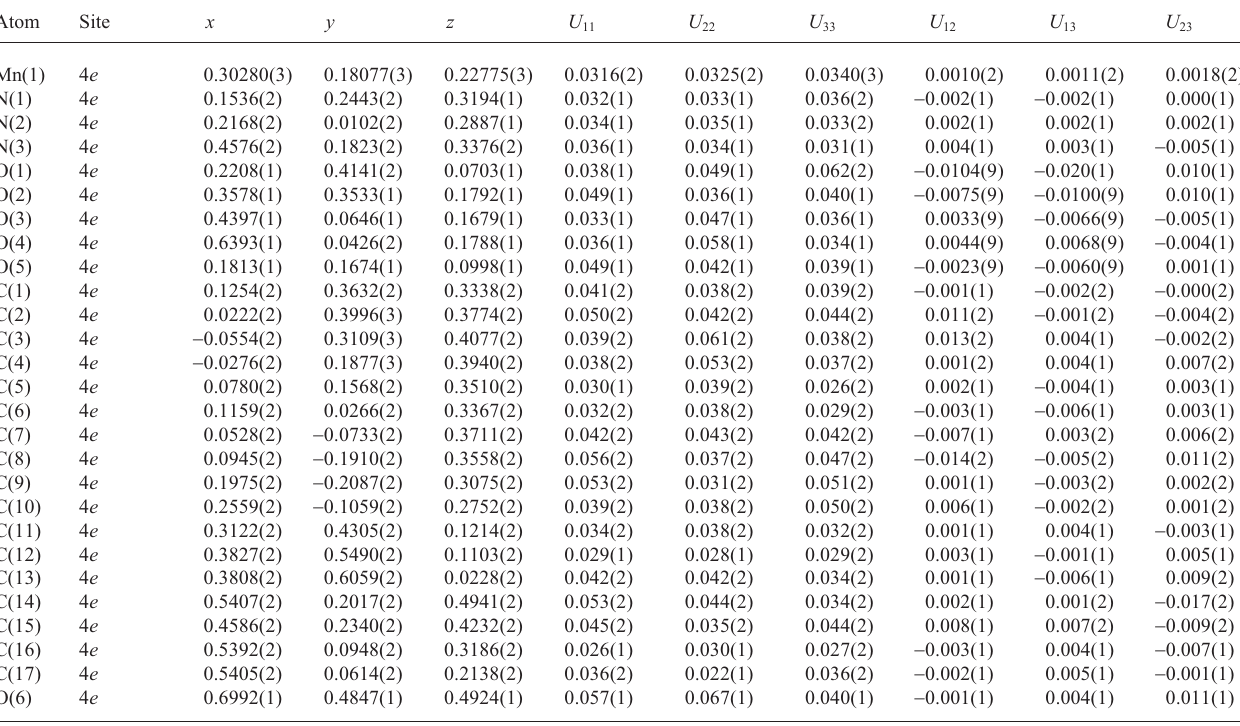
Table 3. Atomic coordinates and displacement parameters (in Å 2 )